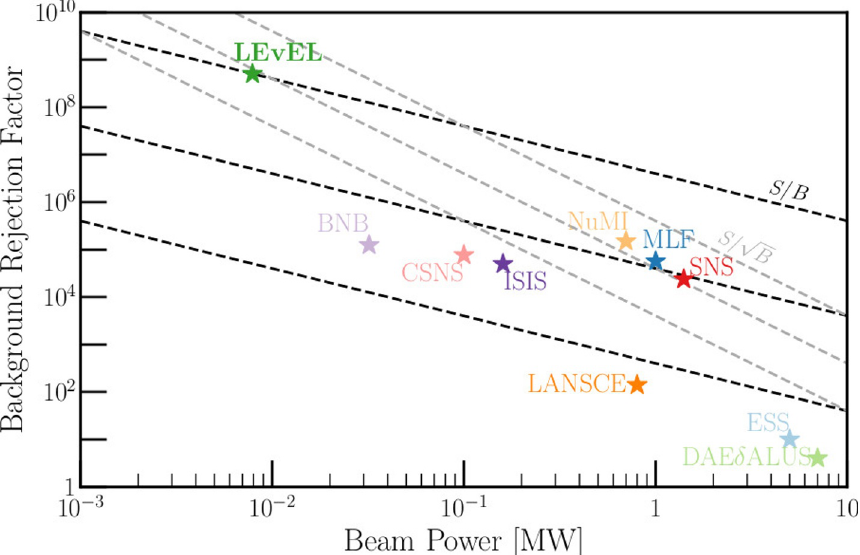
Figure 2. Average power vs. background rejection factor (defined as the ratio between beam-off to beam-on time) for a variety of facilities. Our proposal, labelled “ LEvEL ” is represented by the green star. Other facilities shown are the Booster Neutrino Beam (faint purple, US) [98], China Spallation Neutron Source (pink, China) [99], ISIS Neutron and Muon Source (purple, U.K.) [100], Los Alamos Neutron Science Center (orange, US) [101], J-PARC Materials and Life sciences Facility (blue, Japan) [97], the Neutrinos from the Main Injector beam (NuMI, faint orange, US) [102], the Spallation Neutron Source (red, US) [89], the European Spallation Source (light blue, Sweden) [103], and the proposed DAE δ ALUS source (light green, proposed) [104]. Dashed black lines indicate our simple assumptions for where signal-to-background ratio S/B is constant, and dashed grey lines √ are where signal-to-square-root-of-background S/ B is